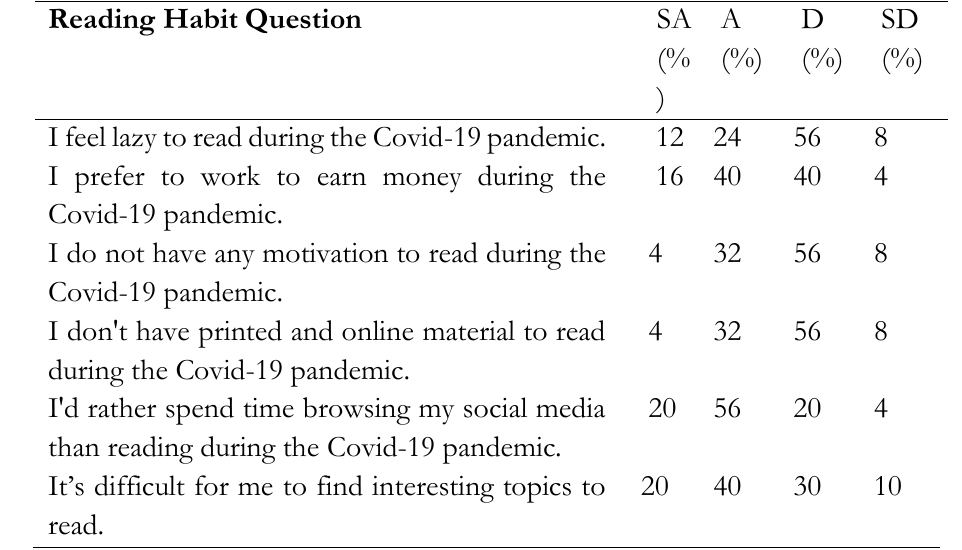
TABLE 3. Factors That Hindered Students’ Pleasure Reading Habit during Covid -19 Pandemic Reading Habit